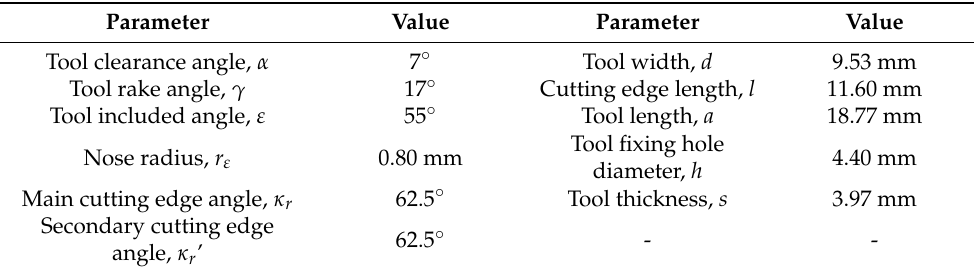
Figure 2. Machining tests setup: ( a ) turning center; ( b ) machined specimen before the finishing operation; ( c ) cutting tool and tool holder; ( d ) tool geometry. Table 3. Tool geometry main parameters.